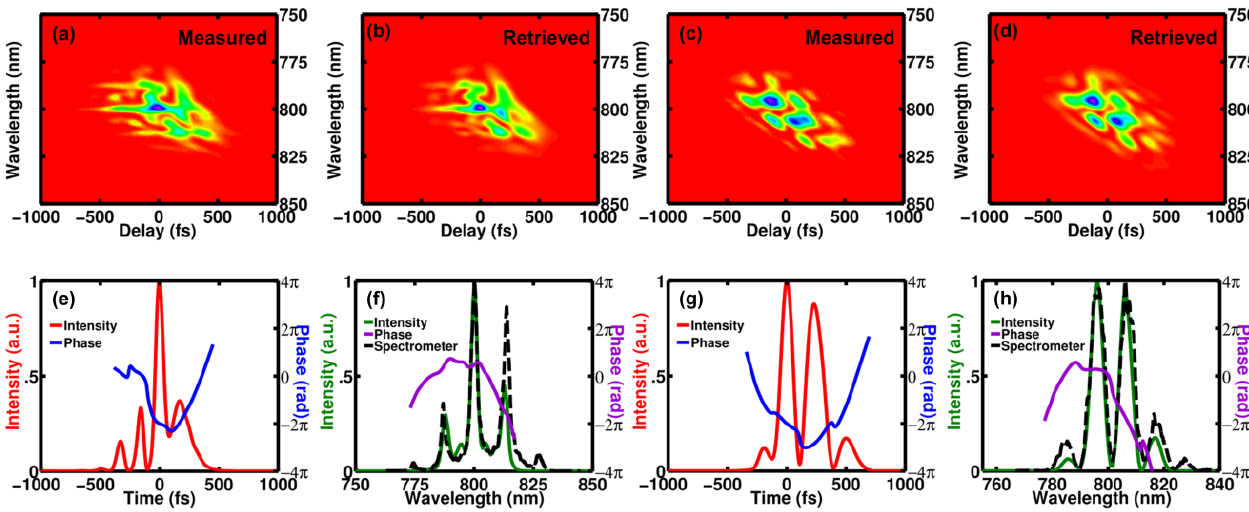
Figure 11. The measured trace for ( a ) a chirped pulse train and ( c ) a chirped double pulse. The retrieved trace ( b ) and ( d ) with FROG error of 0.81% and 0.74% for ( a ) and ( c ), respectively. ( e ) and ( g ), retrieved pulse intensity and phase in temporal domain showing structures from chirped pulse beating. ( f ) and ( h ), the measured spectrum and the spectral phase compared with measurement made by a spectrometer